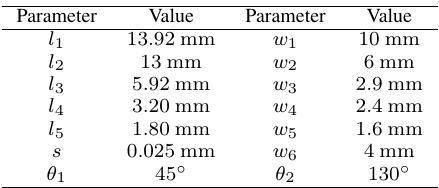
TABLE 1: Optimum Values of the Design Parameters